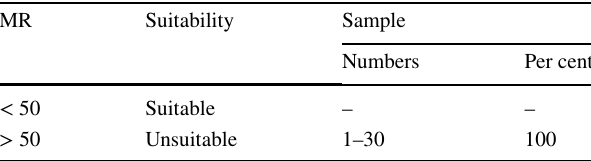
Table 11 Classification of MR for irrigation (Szaboles and